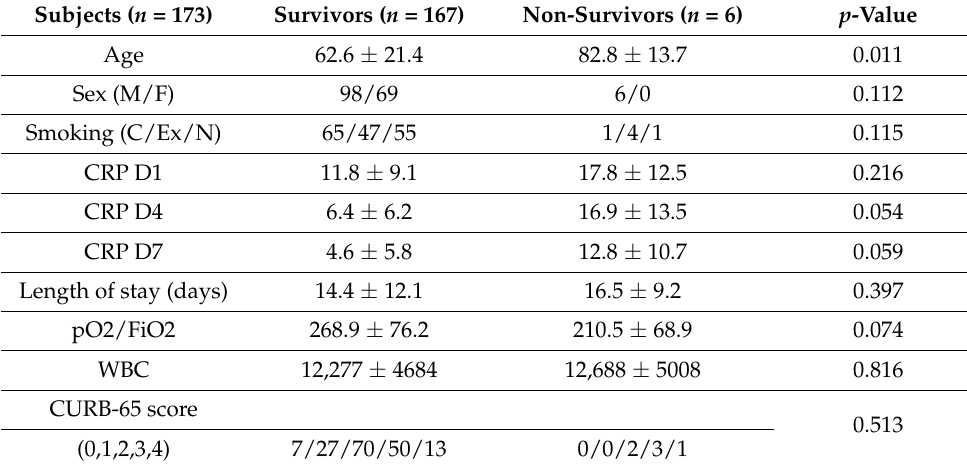
Figure 1. Flowchart of the study participants. Table 1. Characteristics of patients with CAP.